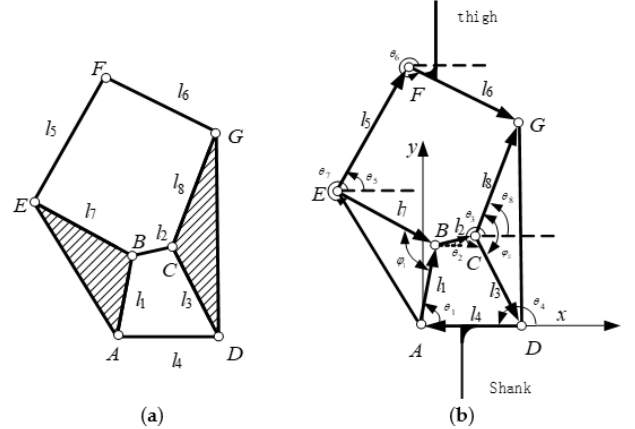
Figure 8. 6-bar mechanism model. ( a ) Sketch of 6-bar mechanism ( b ) Vector illustration of 6-bar mechanism.